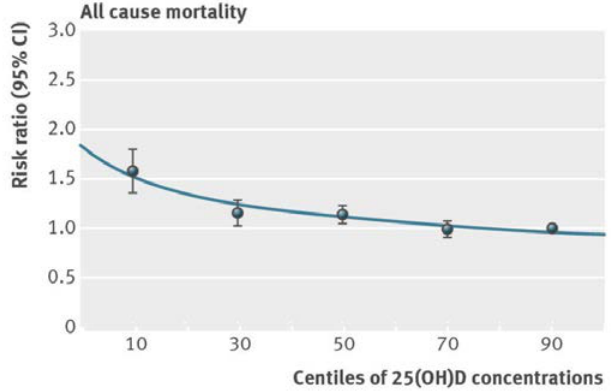
Figure 2. All-cause mortality is higher with low 25(OH)D serum levels (≤10